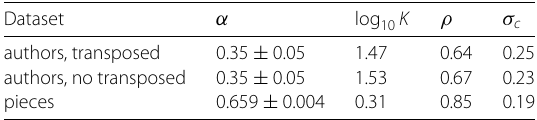
Table 3 Results of fitting a regression line to the scatter plot between log 10 V and log 10 L , as log 10 V = log 10 K + α log 10 L (Heaps’ law), with correlation coefficient ρ . The value of σ c is also shown. Three cases are compared: composers with transposition (our main case of study), composers without transposition (for the sake of comparison), and individual pieces (for which transposition has no effect on L and V